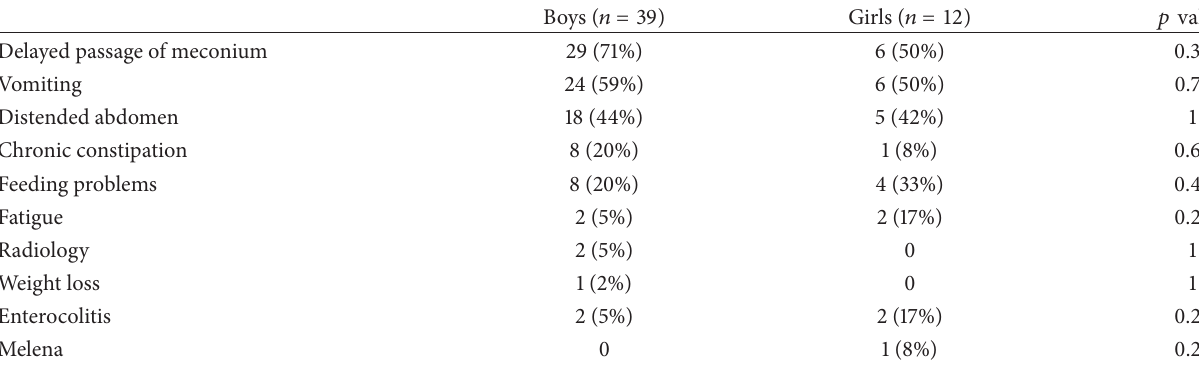
Table 3: Presenting symptoms.